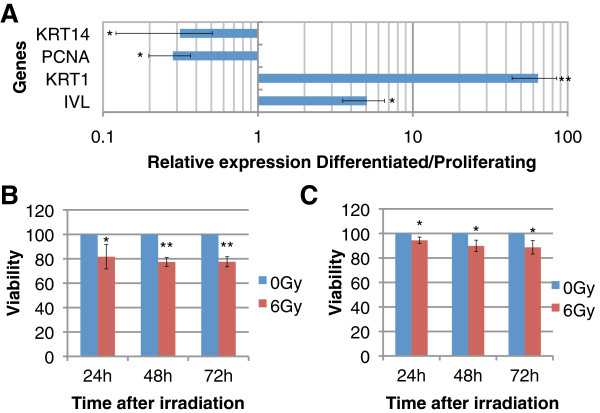
Characterization of the cellular model. (A) RT-qPCR analysis of epidermal basal cells markers (PCNA, KRT14) and suprabasal cells markers (IVL, KRT1) between proliferating and 3-days differentiated keratinocytes (n=3; error bars represent SD; bilateral paired t-test: *p≤0.05, **p≤0.01). (B) Viability assay between 6Gy-irradiated and sham-irradiated proliferating keratinocytes. Results are expressed as the mean percentage of viable cells assuming 100% viability for non-irradiated cells (n=3; error bars represent SD; bilateral paired t-test : *p≤0.05, **p≤0.01, ***p≤0.001). (C) Viability assay between 6Gy-irradiated and sham-irradiated differentiated keratinocytes. Results are expressed as the mean percentage +/− SD of viable cells of 4 independent experiments assuming 100% viability for non-irradiated cells (bilateral paired t-test: *p≤0.05).